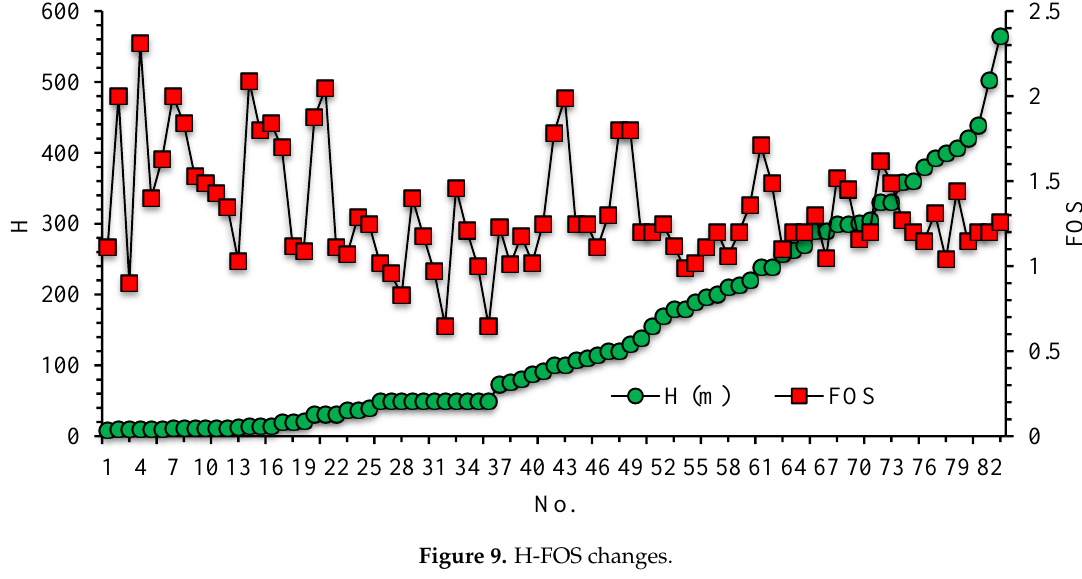
Figure 9. H-FOS changes.